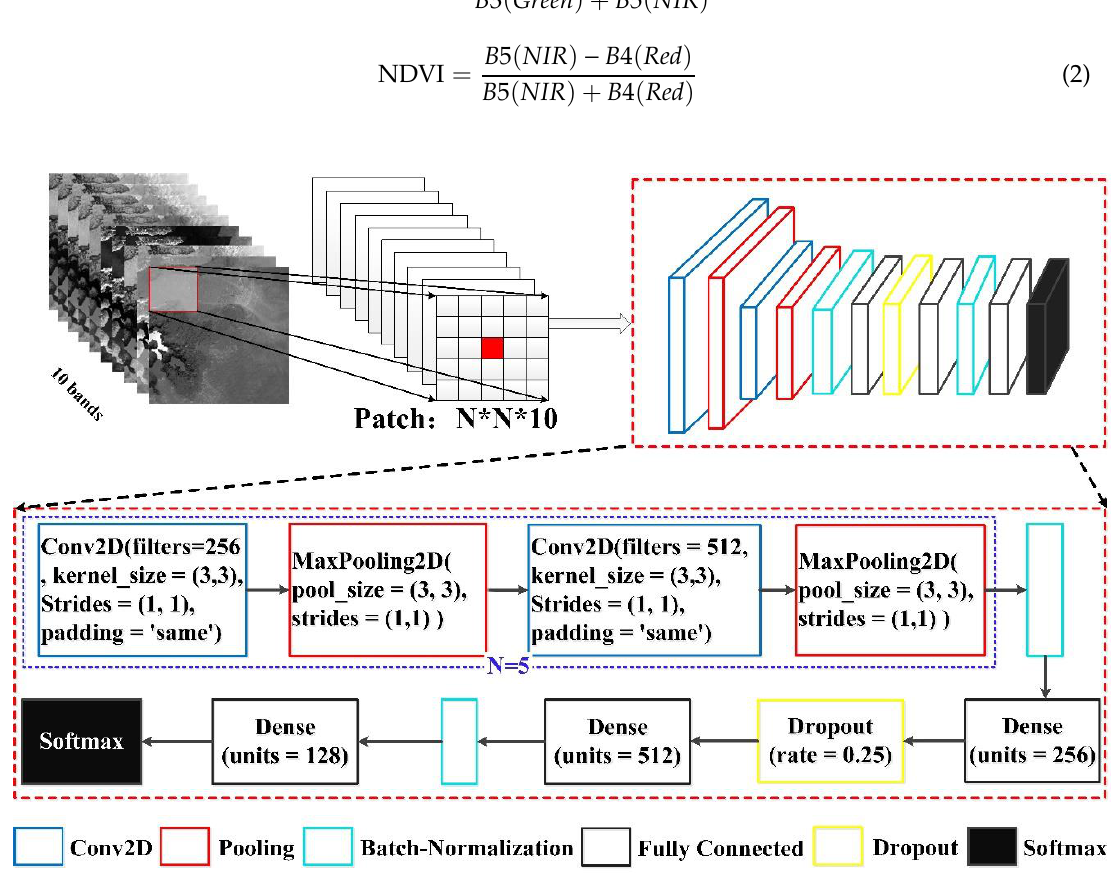
Figure 5. Framework structure of the Convolutional Neural Networks (CNN).